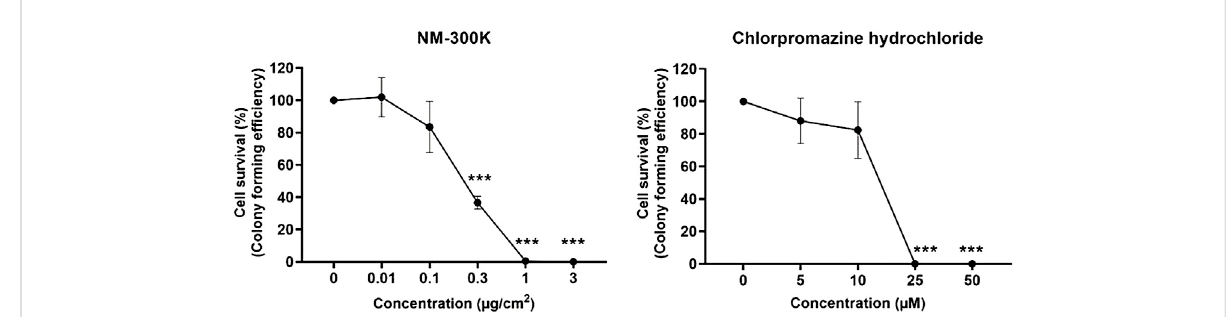
FIGURE 3 Relative colony forming ef fi ciency (RCFE) on A549 cells exposed to nanosilver NM-300 K (JRC Nanomaterials Repository). Characterization information in El Yamani et al., 2017; Elje et al., 2020; Gábelová et al., 2017) (left image) and positive control chlorpromazine hydrochloride (right image) in 12-well plates. No colonies were seen at higher concentrations up to 75 μ g/cm 2 NM-300 K or 1,000 µM chlorpromazine hydrochloride (highest concentrations now shown). Results are presented as mean ± standard deviation of two independent experiments (n = 2), each